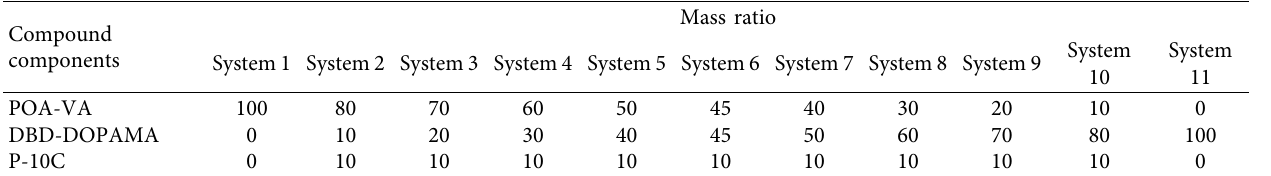
Figure 4: Complex viscosity reducing and wax inhibiting system. Table 2: Compound viscosity reducing and wax suppression system.